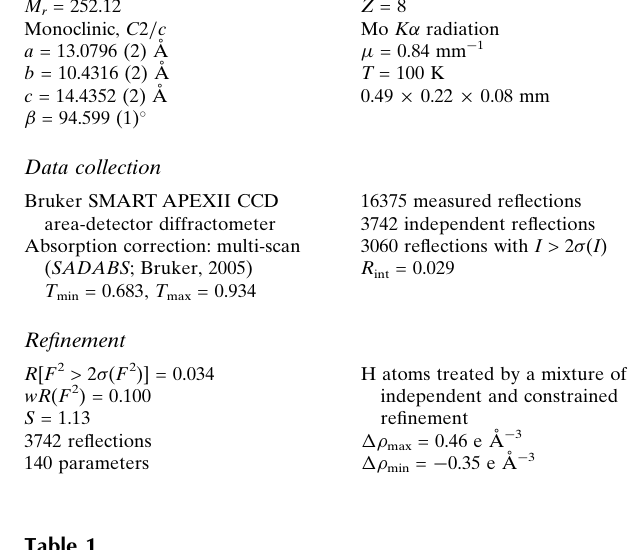
Data collection Bruker SMART APEXII CCD area-detector diffractometer Absorption correction: multi-scan ( SADABS ; Bruker, 2005)